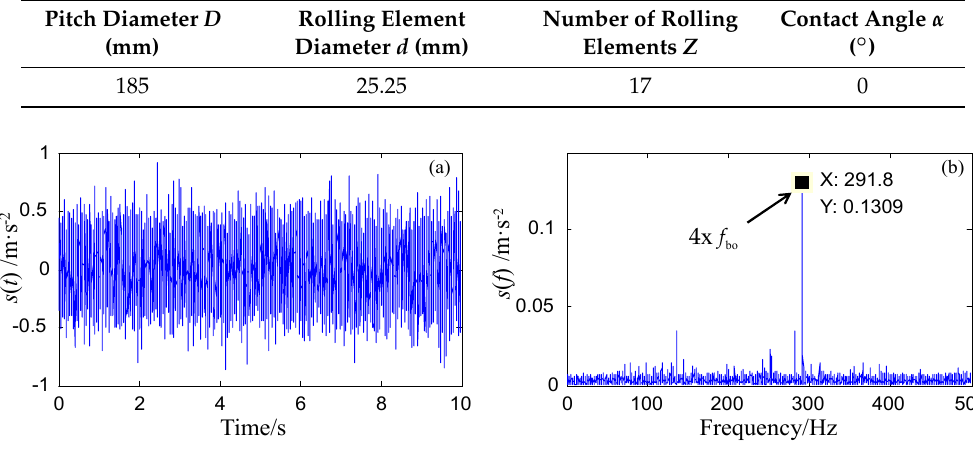
Figure 10. Signals recorded from the rolling bearing of the high-speed train.